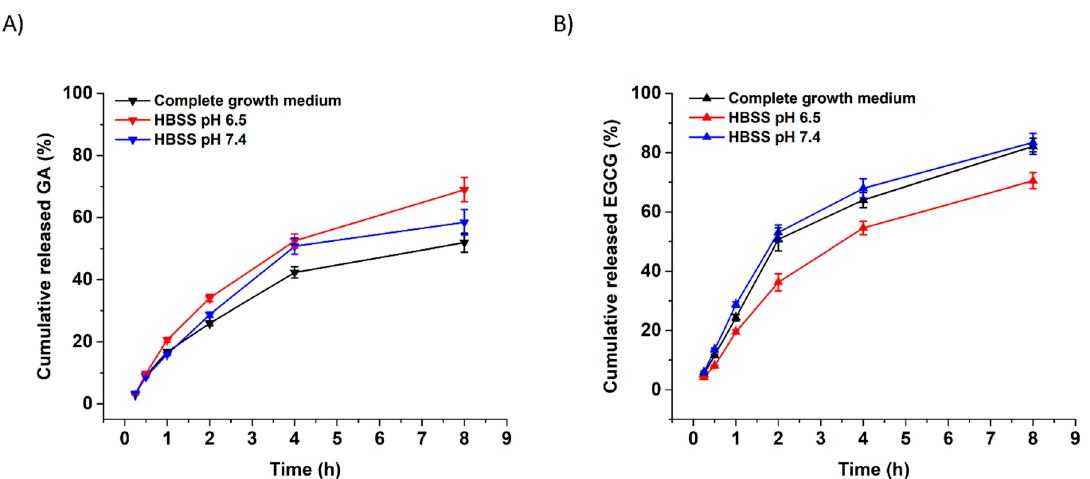
Figure 3. Cumulative in vitro release of GA ( A ) and EGCG ( B ) from xanthan nanofibers. All data were the mean ± SD of three independent experiments.